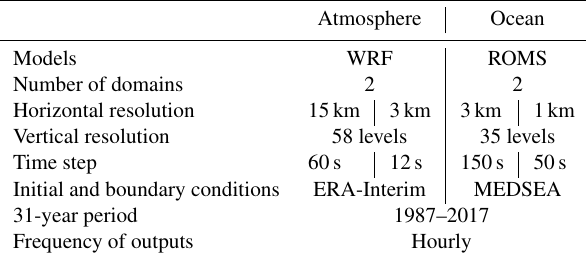
Table 1. Summary of the AdriSC climate component main features for the evaluation